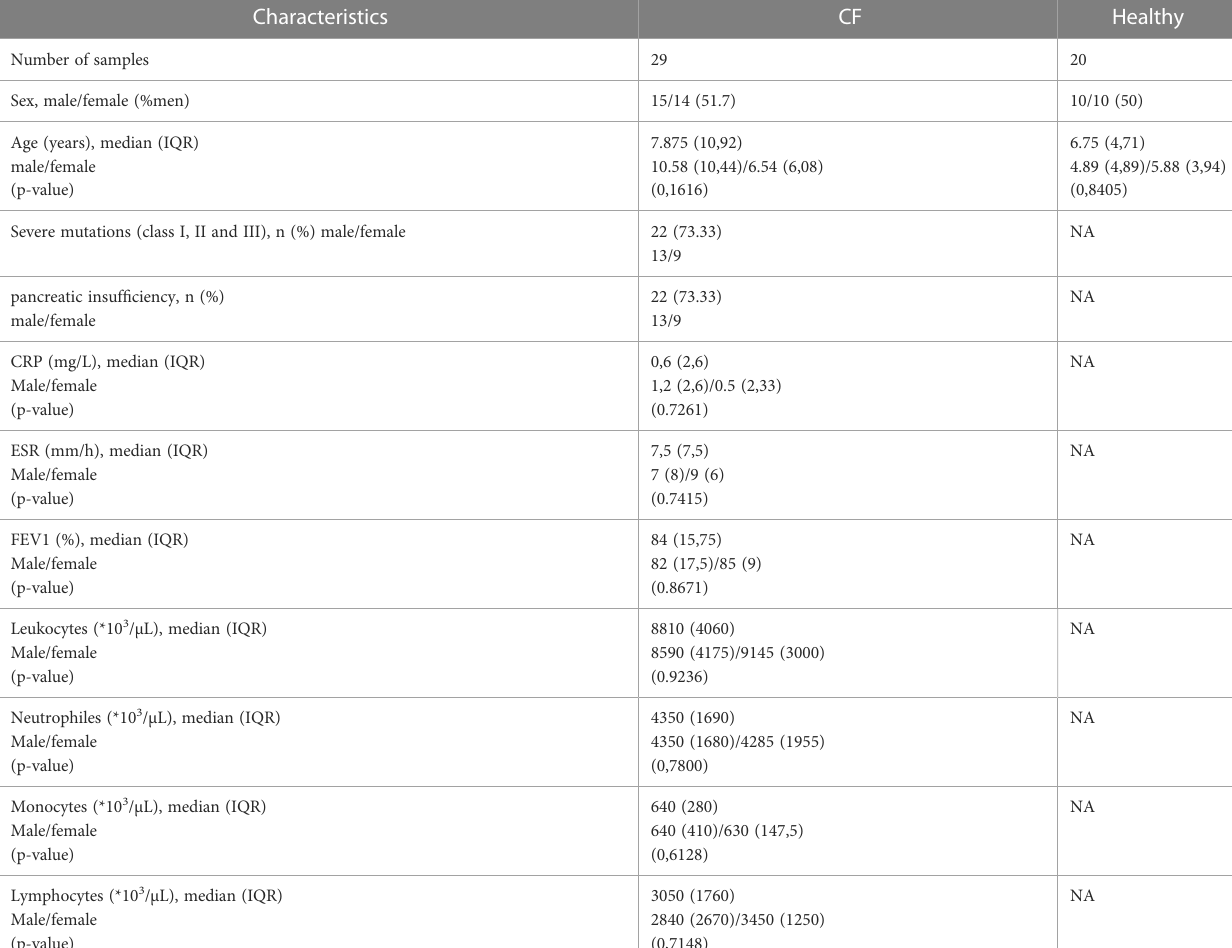
TABLE 1 Characteristics of CF patients and healthy controls enrolled in the study.